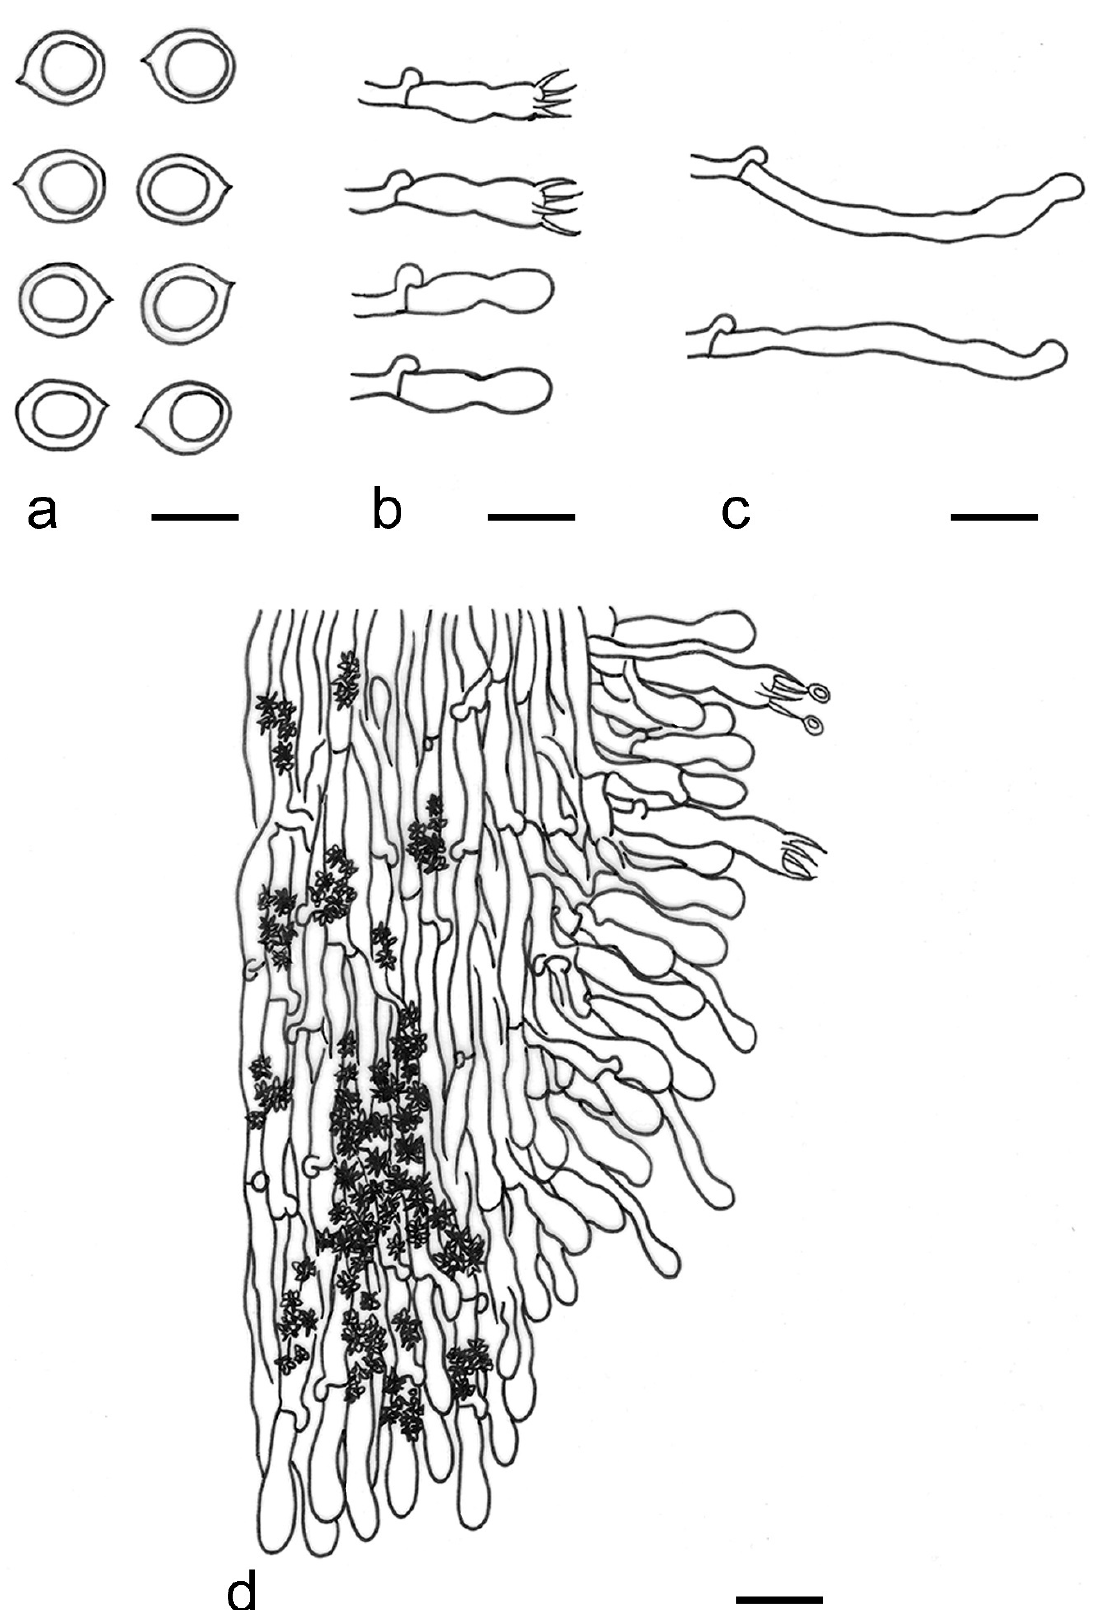
Figure 33. Microscopic structures of Xylodon victoriensis (drawn from the holotype). ( a ) Basidiospores; ( b ) basidia and basidioles; ( c ) leptocystidia; ( d ) a section of the basidiocarp.—Scale bars: a = 5 μ m; b–d = 10 μ m.